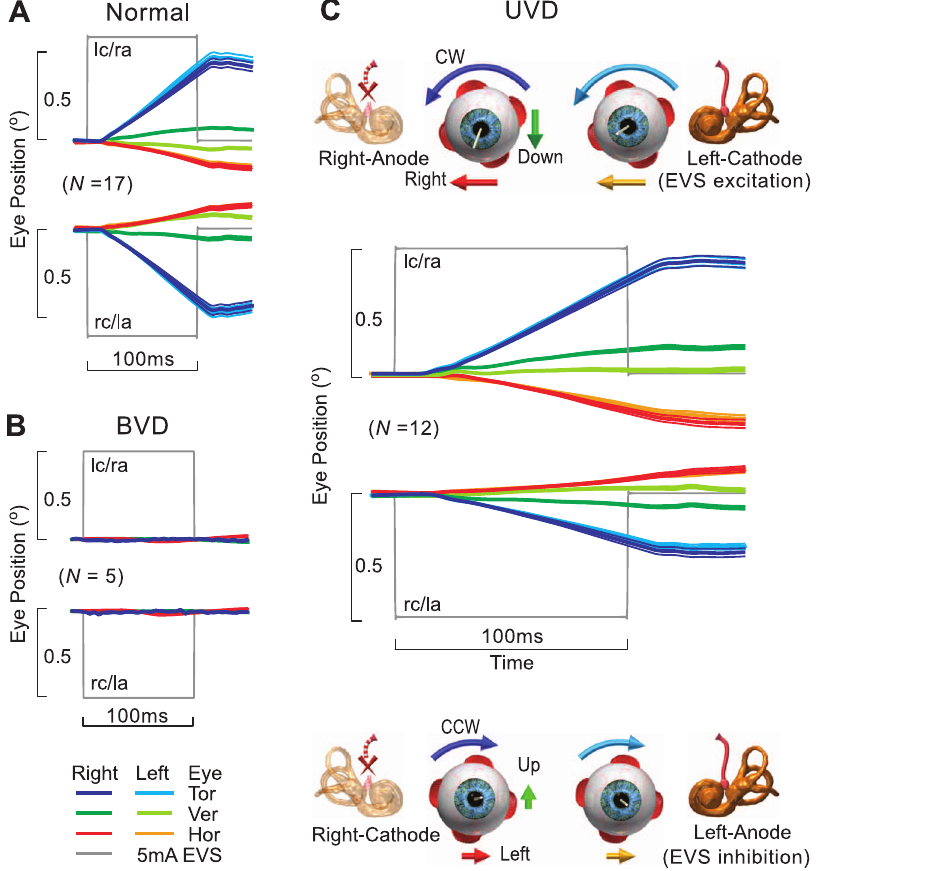
Figure 1. EVORs to human bipolar EVS in healthy subjects, bilateral and unilateral vestibular deafferented patients. (A) Normal eVOR from healthy subjects ( N =17) (group means 6 SEM) comprised conjugate torsional and horizontal eye rotations, binocularly equal in amplitude, rotated away from cathode towards anode, and vertical divergence with the intorting eye upwards (cathode side) and extorting eye downwards (anode side). (B) EVOR was absent from BVD patients ( N =5) with torsional, vertical and horizontal eVOR positions # 0.01 u . (C) Bidirectional eVOR from grouped as right UVD patients with left functioning ear ( N =12). The excitatory eVOR to left-cathode/right-anode (lc/ra) cathodal EVS comprised conjugate torsional and horizontal eye rotations away from cathode and a vertical divergence with the eye on the anodal side moving downwards. The inhibitory eVOR to right-cathode/left-anode (rc/la) anodal EVS was in the opposite direction and at about half the amplitude of the excitatory eVOR with the eye on the anodal side moving upwards. (The schemes illustrate EVS polarities and eye rotation